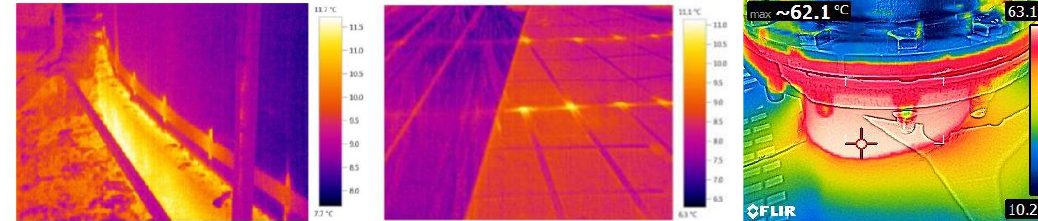
Figure 8. Identified structural thermal bridges during accumulator construction (authors’